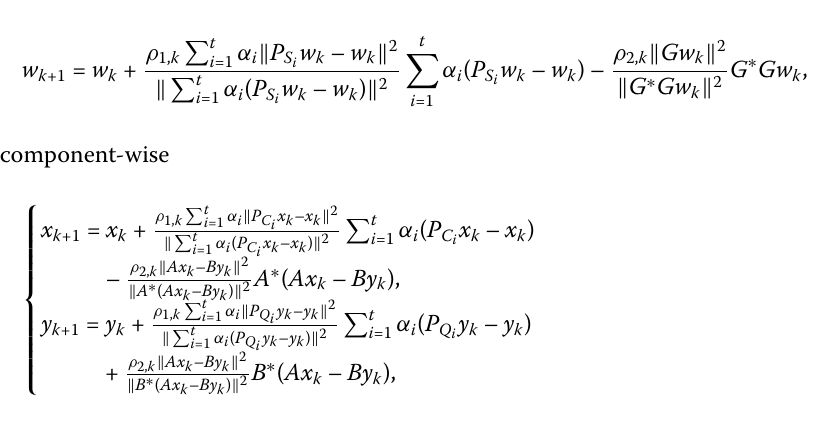
Algorithm 2.10 ([6]) For an arbitrary initial point w 0 = ( x 0 , y 0 ) ∈ H , the sequence { w k } is generated